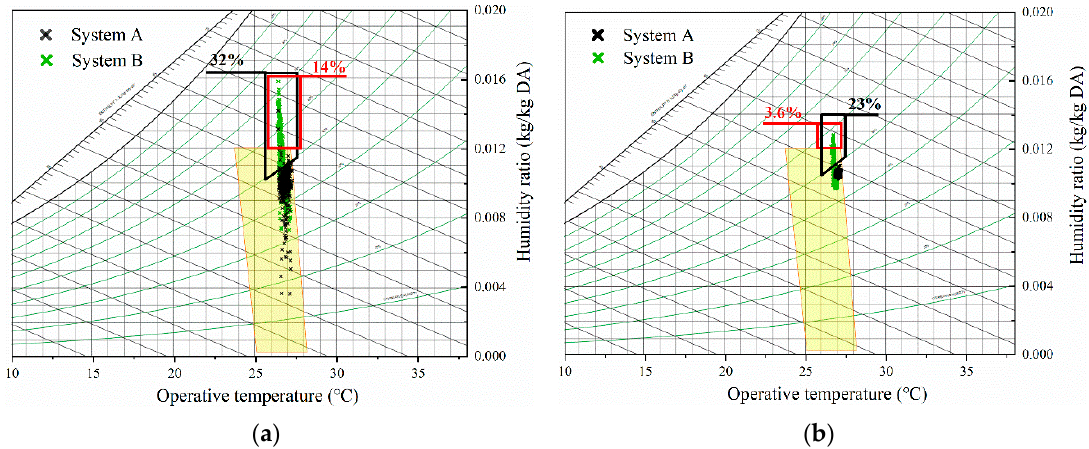
Figure 16. Indoor thermal comfort when HPDC systems operate under different climatic conditions: ( a ) Shanghai’s climate. ( b ) Singapore’s climate.